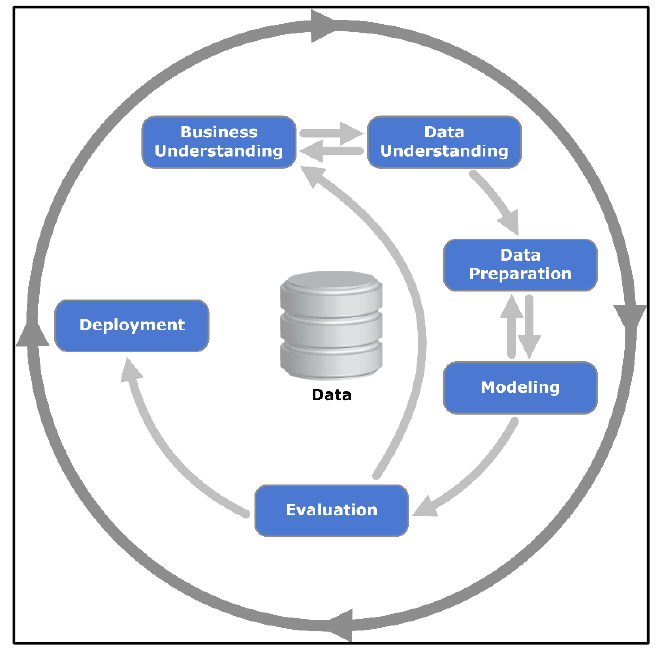
Figure 1. CRISP-DM Process Diagram. Source: CRISP-DM, 2020.